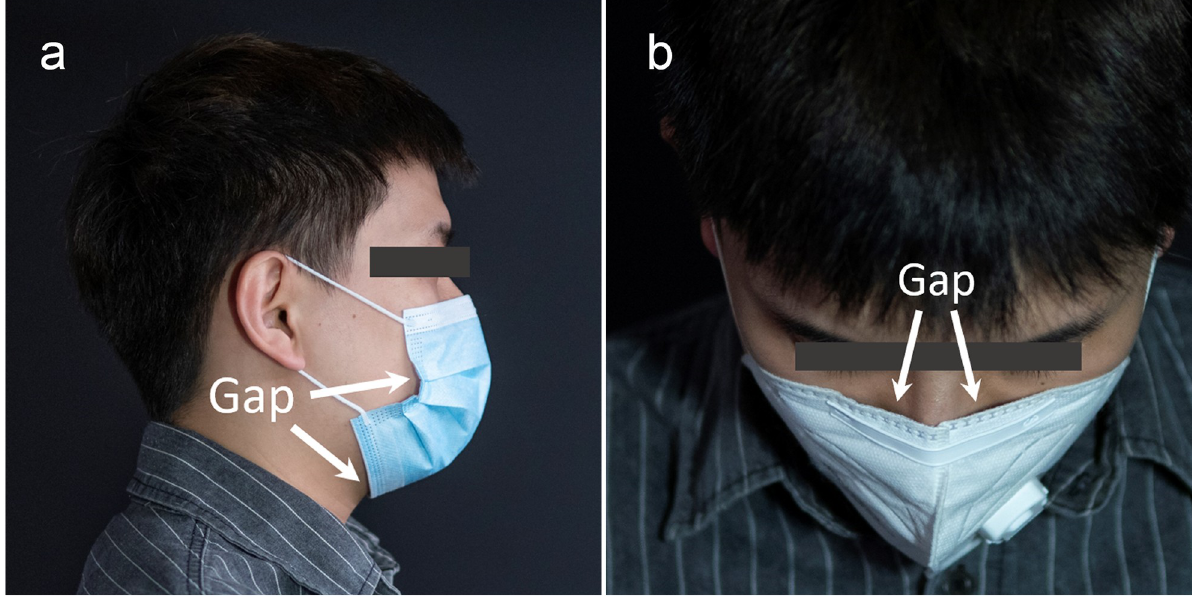
Fig 1. Examples of face-seal gaps. For (a) surgical mask and (b) N95 mask, and arrows indicating in (a) buccal gaps and (b) nasal gaps. The individual in this manuscript has given written informed consent (as outlined in PLOS consent form) to publish these case details.